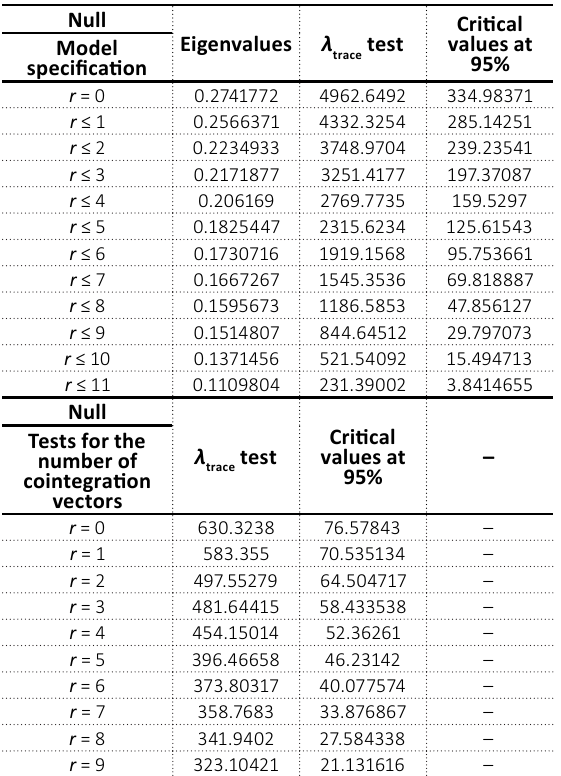
Table 3. Johansen’s test statistics for cointegration rank